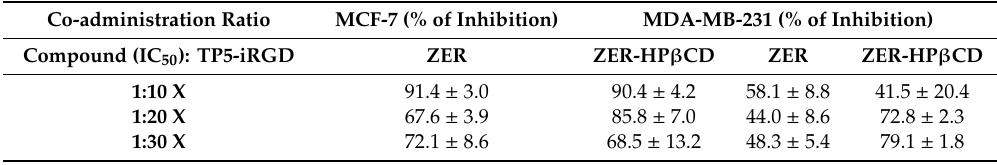
Figure 4. Of cell inhibition (MTT assay) of MCF-7 cells treated with ZER-HP β CD-TP5-iRGD for 72 h. Table 2. Of cell growth inhibition of MCF-7 and MDA-MB-231 breast cancer cells after 72 h of co-administration of ZER or ZER-HP β CD with TP5-iRGD peptide.